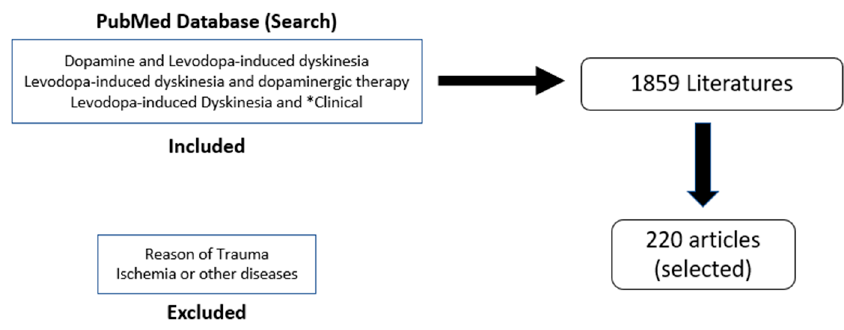
Figure 1: Flow Chart for articles selection and literature search Figure 1. Flow Chart for articles selection and literature